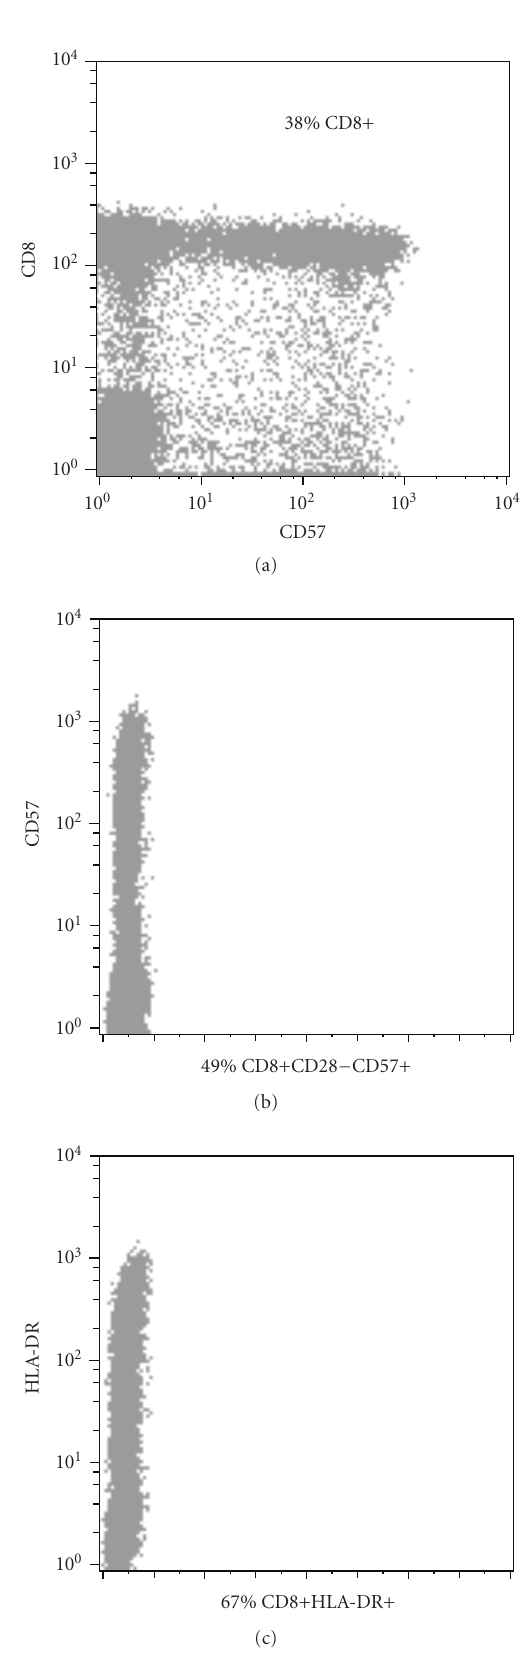
Figure 1: Increased number of CD8+ T cells with a high grade of activation (HLA-DR) and replicative senescence (CD57+).